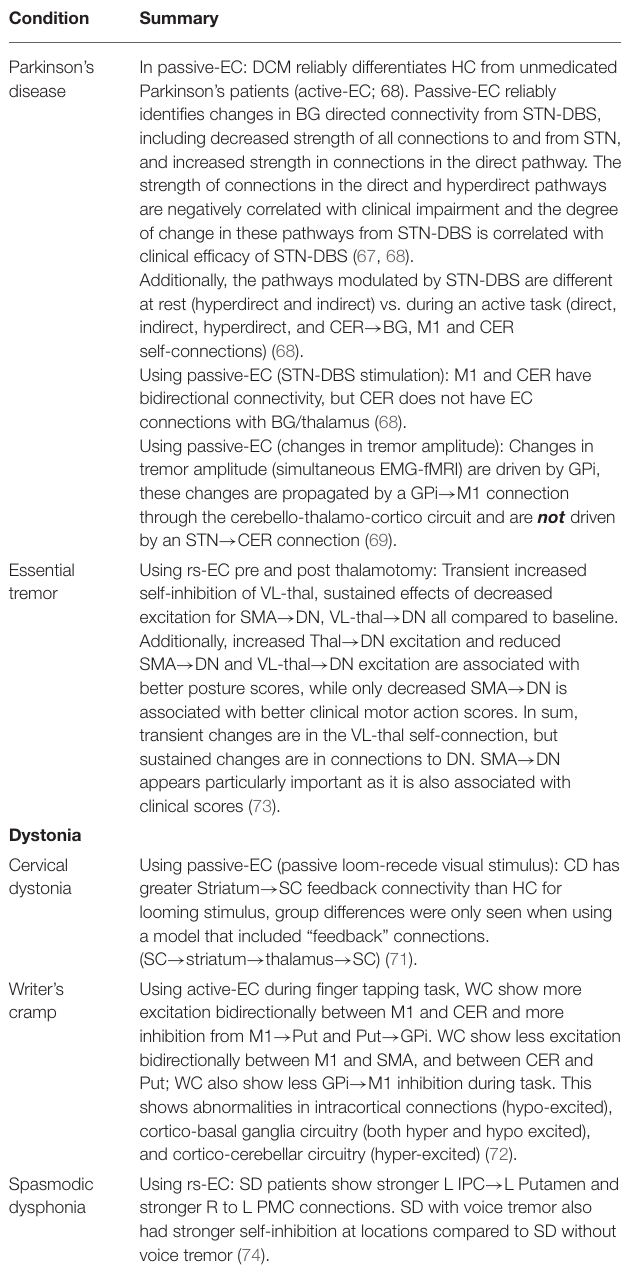
TABLE 2 | Summary of highlights of effective connectivity findings reviewed by